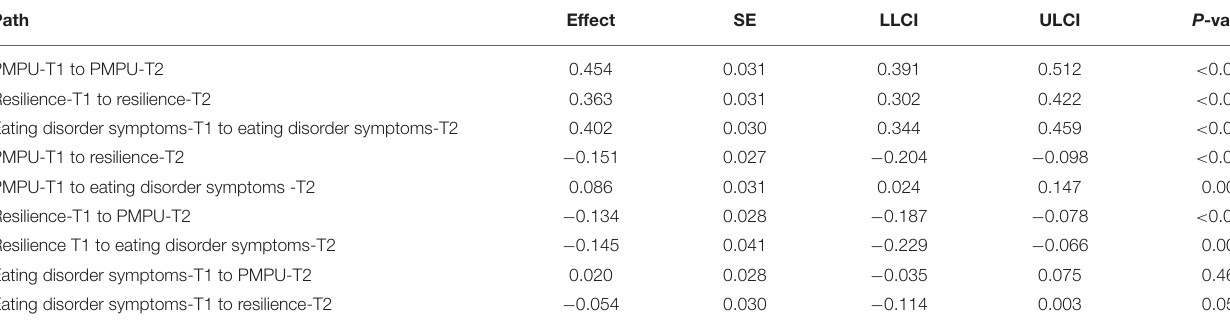
TABLE 3 | Bootstrapped estimation of each path of the reciprocal cross-lagged model.